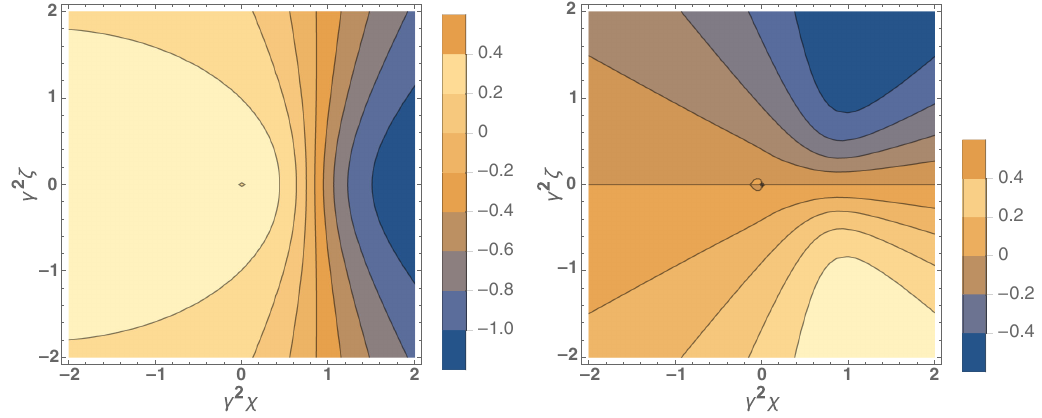
FIG. 4. The horizontal effective potential ð Ψ x − Ψ ϕ Þ ρ 2 =e (left) and the vertical potential Ψ y ρ 2 =e (right) as a function of γ 2 χ and γ 2 ζ at a longitudinal position of ξ ¼ 1 = 300 γ 3 with γ ¼ 500 .